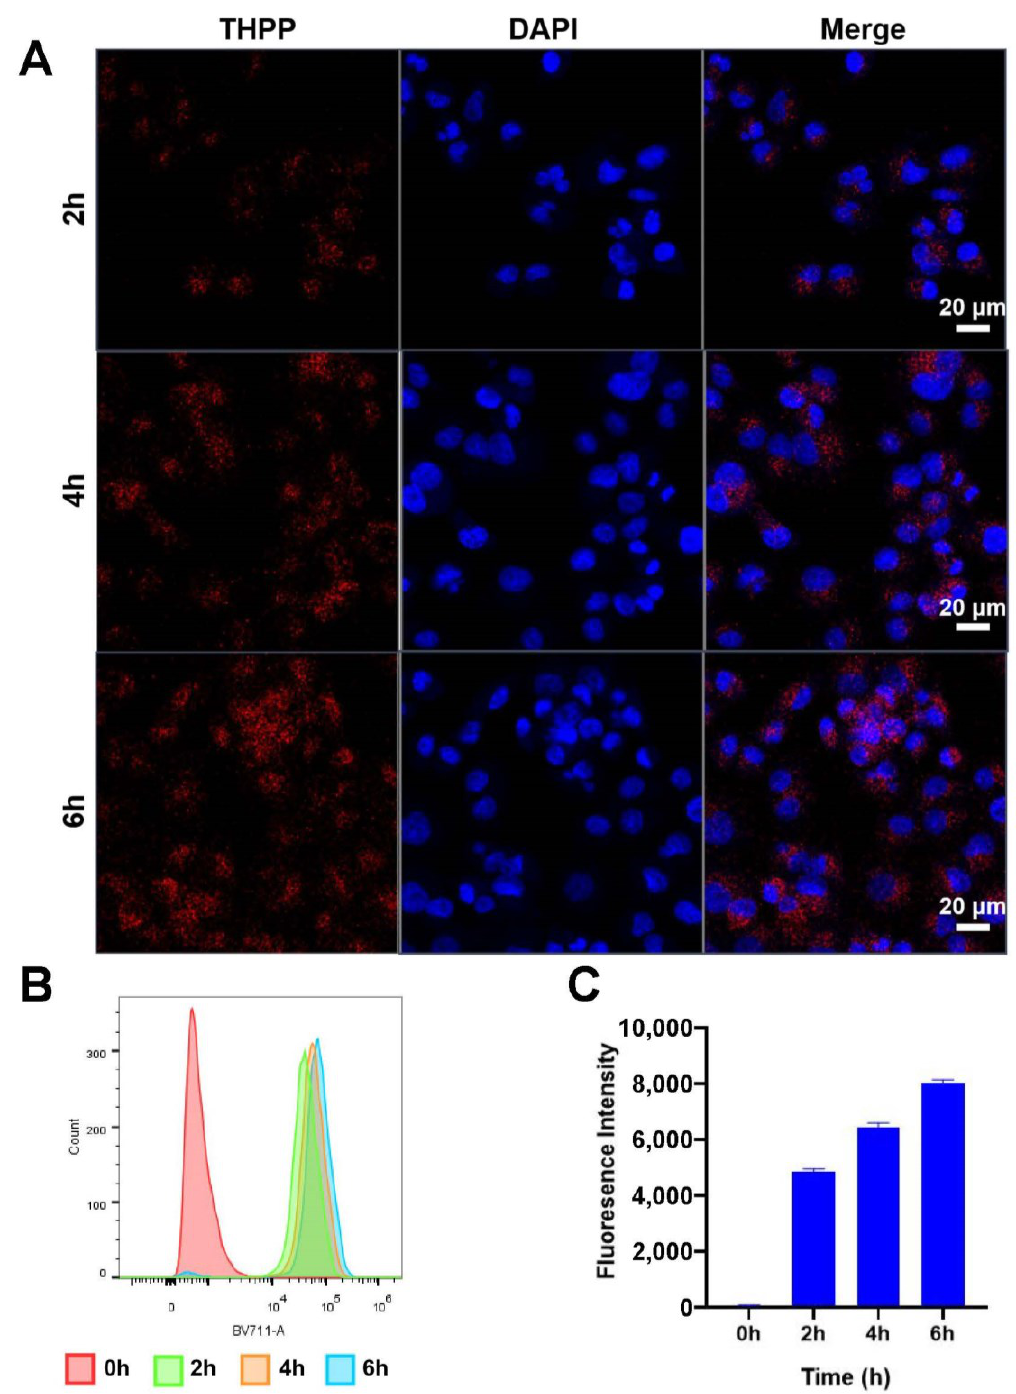
Figure 2. TPG NPs cellular uptake efficiency of PANC-1 cells. ( A ) Confocal microscopy images of PANC-1 cells after cells were incubated with TPG NPs for 2 – 6 h (scale bar = 20 μm; red: THPP; blue: DAPI); Flow cytometry analyzing result ( B ) and the quantitative data ( C ) of THPP fluorescence signal positive PANC-1 cells after being co-incubated with TPG NPs for 2 – 6 h.